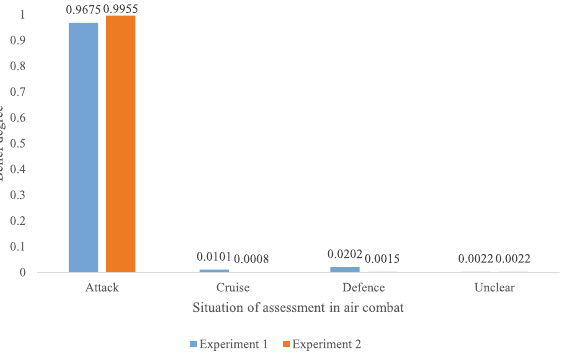
Figure 3. The comparison results between Experiment 1 and Experiment 2 on the situation